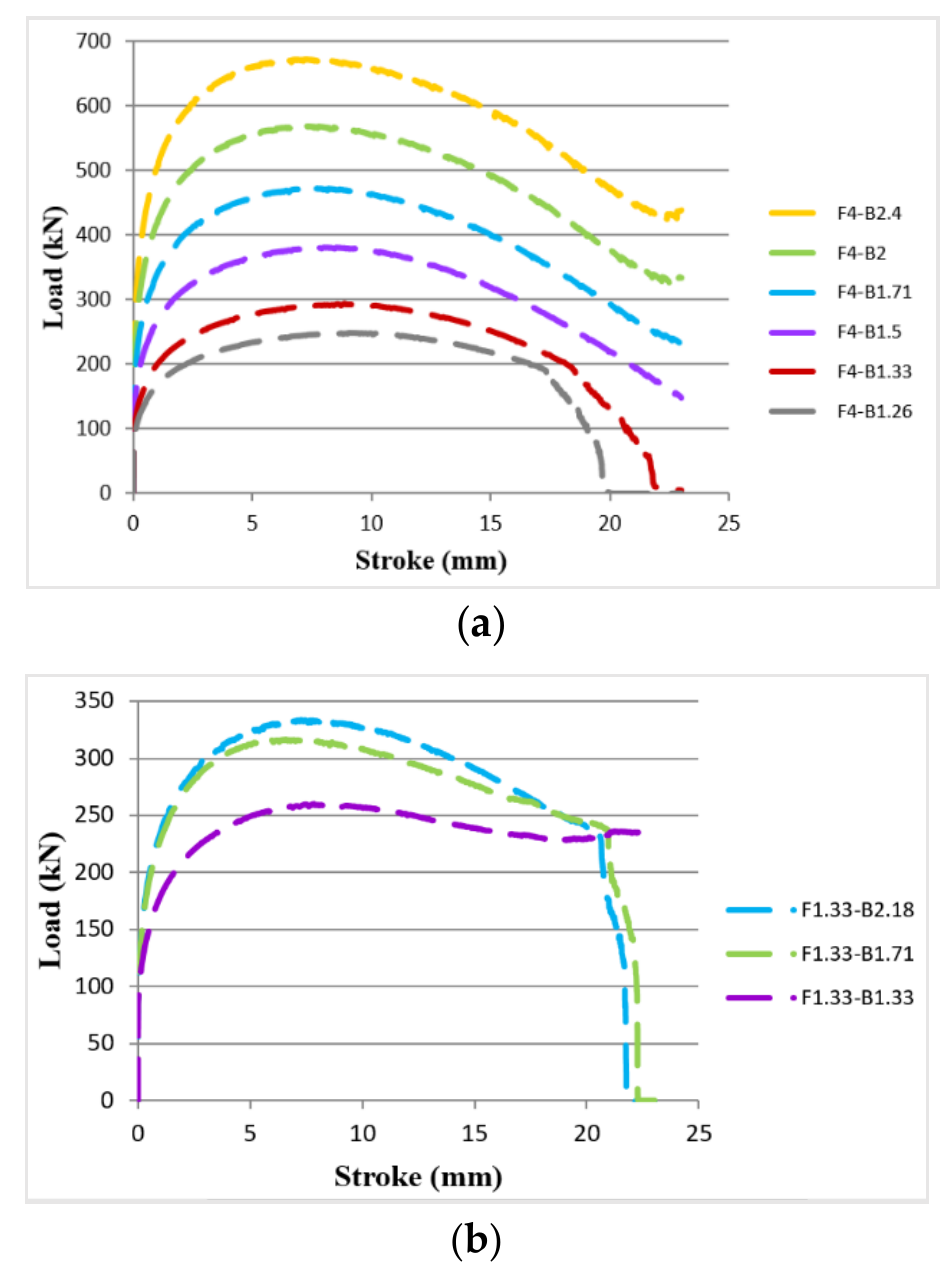
Figure 7. Forming load-stroke curves from DEFORM simulation for ( a ) FER fixed at 4, and ( b ) FER fixed at 1.33.